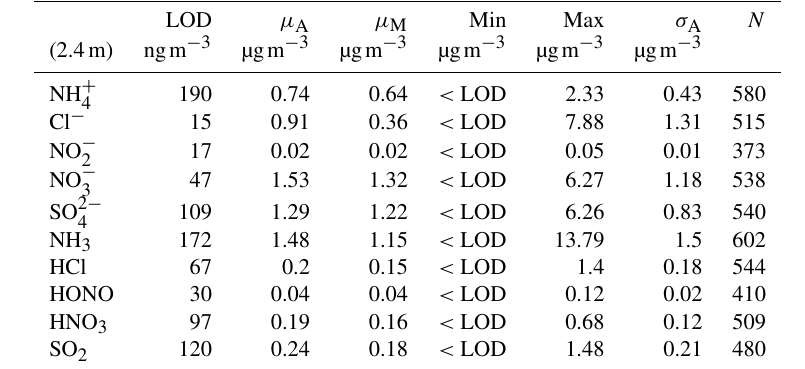
Table 1. Limit of detection (LOD, determined as 3 standard deviations from average baseline signal), mean ( µ A ), median ( µ M ), min, max and arithmetic standard deviation ( σ A ) for concentrations measured at 2.4m for trace gas and water-soluble aerosols measured during the Easter Bush campaign, calculated from hourly data. Number of measurements ( N ) for each compound is also shown.